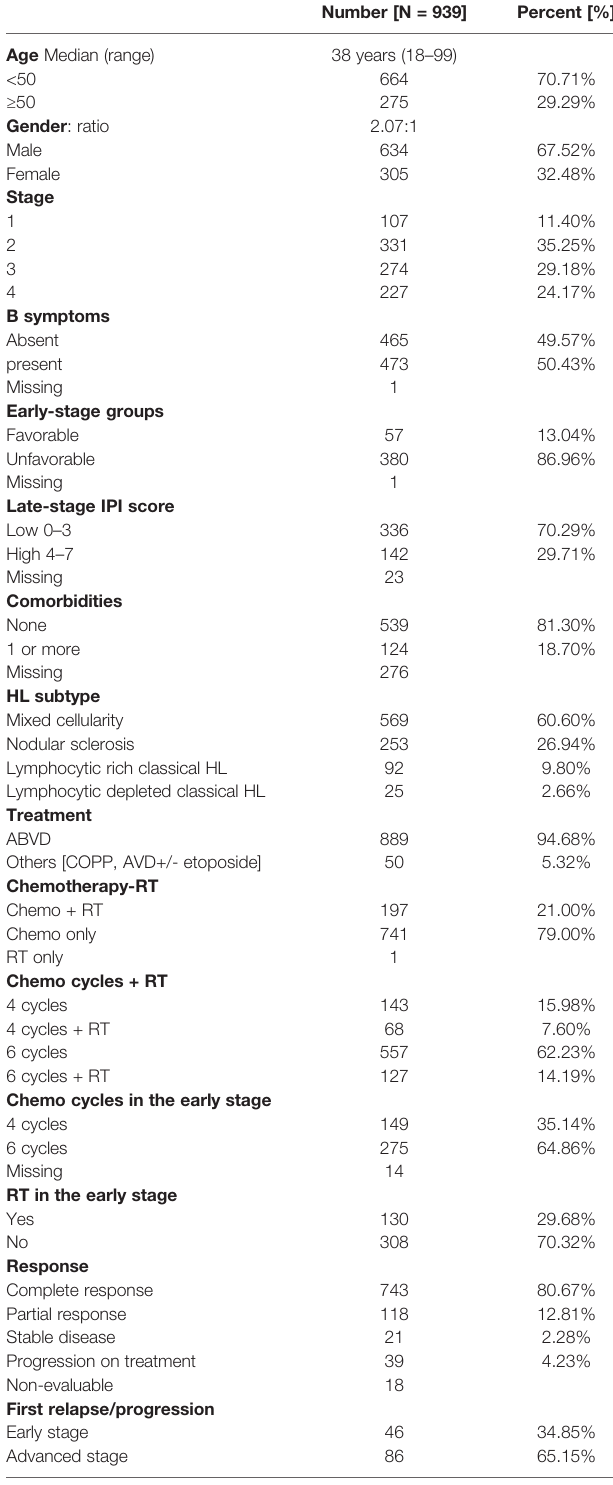
TABLE 1 | Clinical characteristics at presentation, treatment, and response of 939 patients with classical Hodgkin